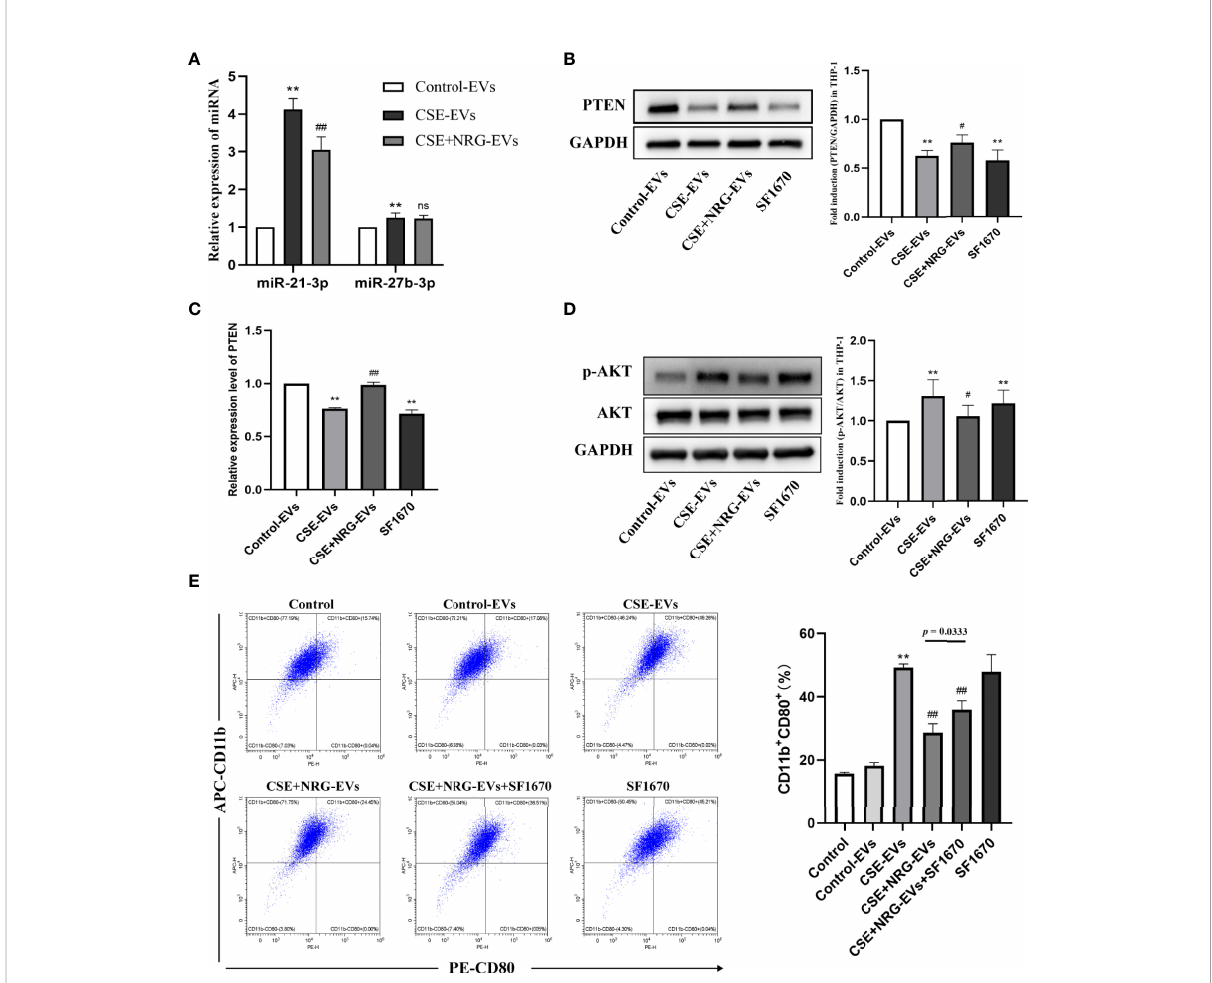
FIGURE 6 Naringenin downregulated BEAS-2B-derived EVs miR-21-3p which targeted tensin homolog deleted on chromosome ten/protein kinase B (PTEN/AKT) cascade thereby suppressing M1 macrophage polarization. (A) Quantitative real-time PCR (qRT-PCR) was performed to detect the expression levels of miR-21-3p and miR-27b-3p in EVs (n = 5). (B) Expression of PTEN was quanti fi ed using western blot analysis (n = 6). (C) The mRNA level of PTEN was determined using qRT-PCR analysis (n = 6). (D) Western blotting was utilized for the p-AKT/AKT level (n = 6). (E) The CD11b + CD80 + THP-1 macrophages treated by EVs or SF1670 (PTEN inhibitor) were indicated by fl ow cytometry (n = 3). ** p <0.01 vs . Control- EVs group. # p <0.05, ## p <0.01 vs . CSE-EVs